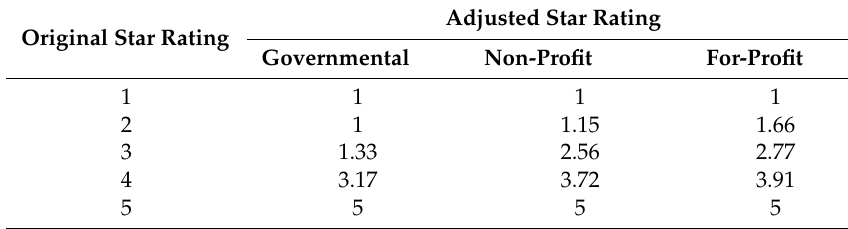
Table 8. Adjusted star rating for the summary star rating